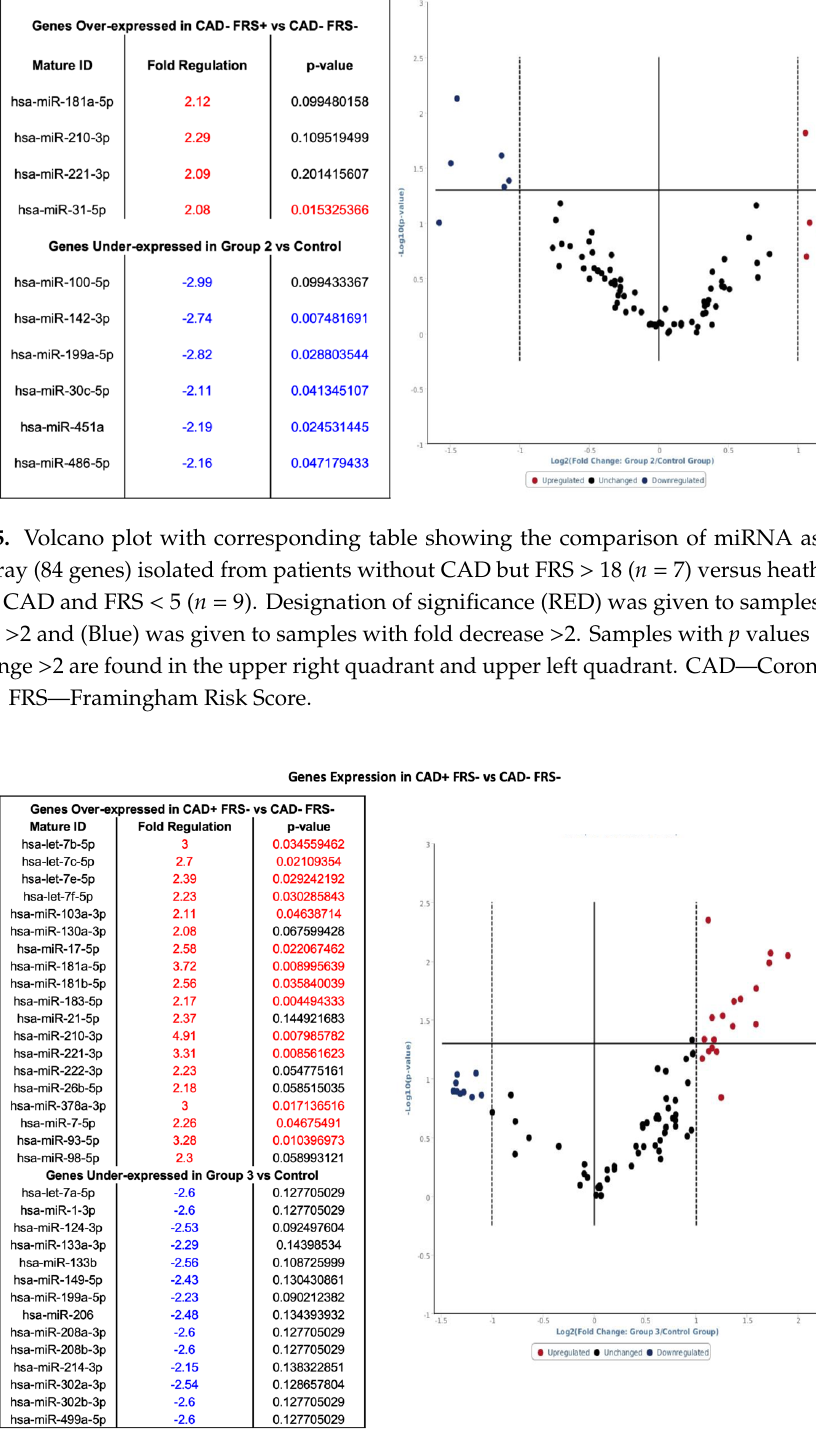
Figure 6. Volcano plot with corresponding table showing the comparison of miRNA assessed by microarray (84 genes) isolated from patients with CAD and FRS < 5 ( n = 7) versus heathy controls without CAD and FRS < 5 ( n = 9). Designation of significance (RED) was given to samples with fold increase >2 and (Blue) was given to samples with fold decrease >2. Samples with p values < 0.05 and Figure 2. are found in the upper right quadrant and upper left quadrant. CAD—Coronary Artery Disease. FRS—Framingham Risk Score.